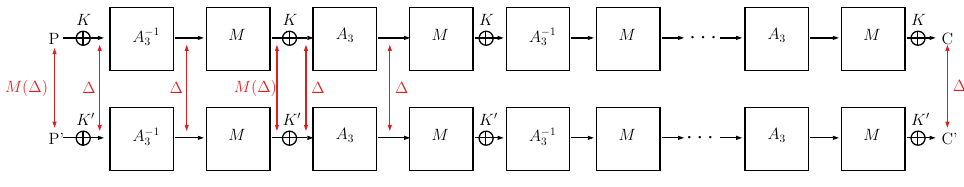
Figure 12: Complementation-like property of MOE : if we denote ∆ = (0 · · · 01), the differential characteristic depicted here holds with probability